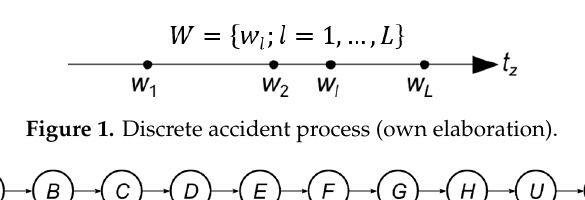
Figure 2. Accident model in the form of a sequence of events that illustrate the circumstances of an accident and its course (own elaboration).